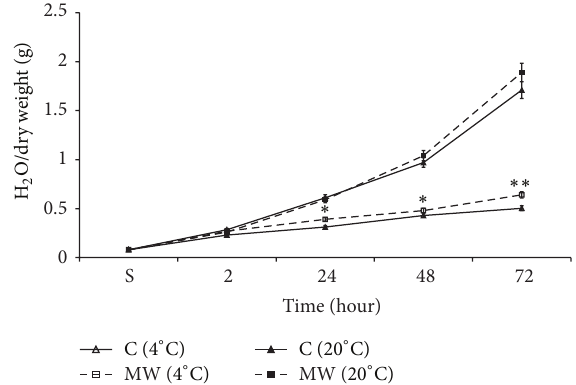
Figure 8: Time-dependent changes in seed hydration during 72 hours of incubation in MW treated (gray column) and nontreated Sham (clear column) DW in cold (4 ∘ C; clear/grey with no pattern markings) and warm (20 ∘ C; clear/grey with horizontal pattern markings) conditions. The time (in hours) of seeds incubation on abscissa and the value of seed hydration (mg of H 2 O for 1mg of dry weight) on ordinate are presented. The results are shown as mean ± SEM ( 𝑛 = 300 ) from three independent experiments, 100 seeds from each experiment. ∗ 𝑃 < 0.05 , compared with Sham, ∗∗ 𝑃 < 0.01